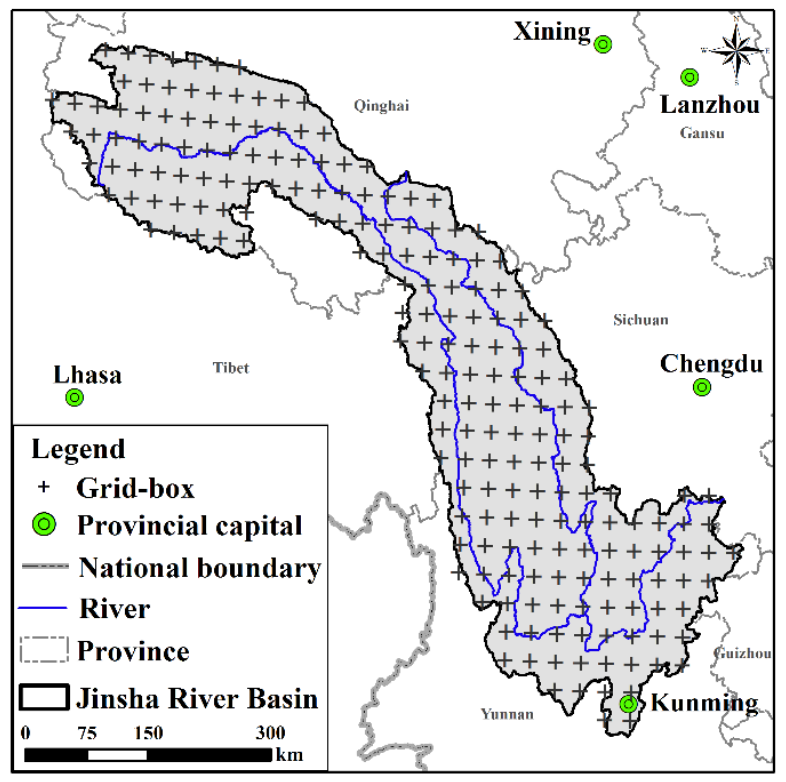
Figure 3. Grid boxes in the JRB.